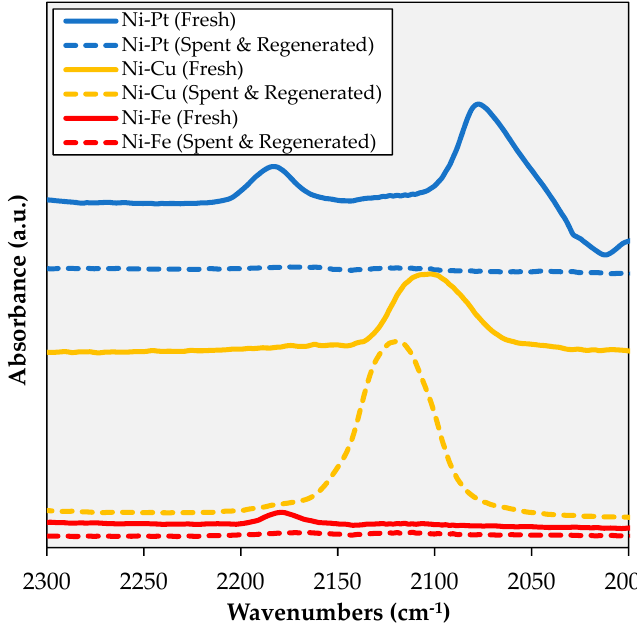
Figure 9. CO-DRIFTS of the catalysts studied.